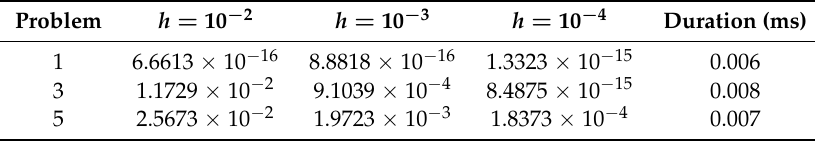
Table 5. Absolute errors at the last mesh point over [ 0,1 ] with ν =